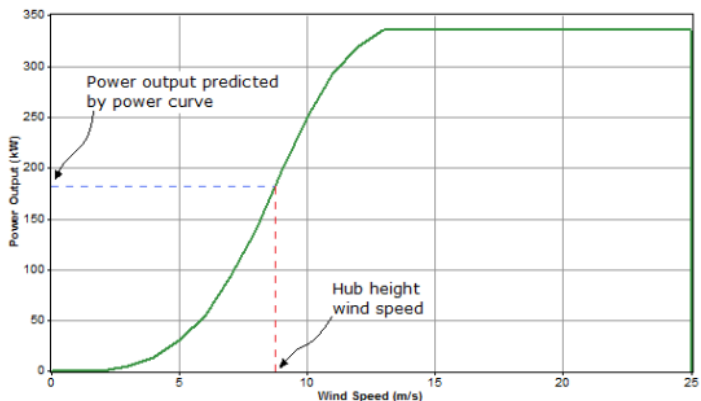
Figure 9. Wind speed to power output transformation graph, based on the input data from [24].